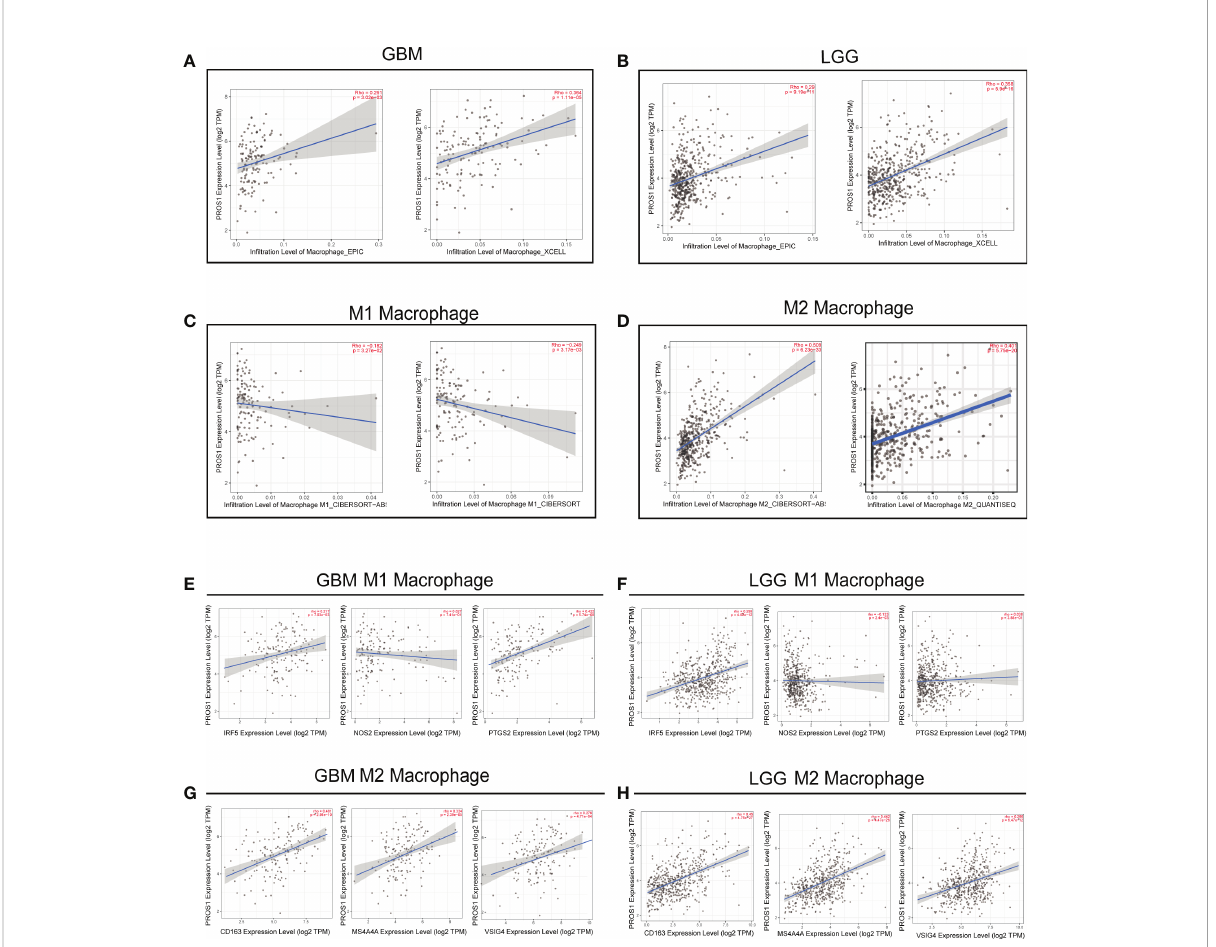
FIGURE 5 PROS1 expression correlates with marker sets of immune cells in GBM and LGG. (A – D) The correlation of PROS1 expression with Macrophages, M1 macrophages, and M2 macrophages in fi ltration level in glioma from the TIMER2.0 database. Scatter plots illustrate correlations between PROS1 expression and markers of M1 (IRF5, NOS2 and PTGS2) (E, F) , and M2 macrophages (CD163, MS4A4A, VSIG4) (G, H) in GBM and